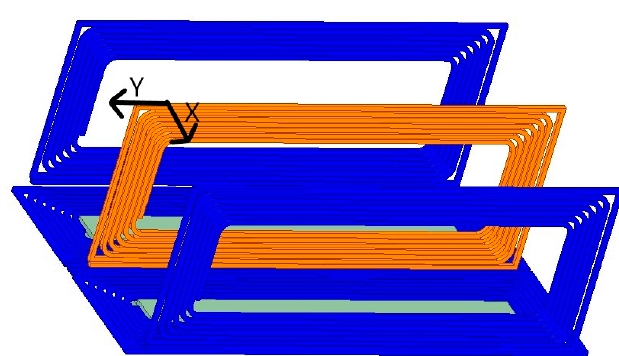
Figure 2. Concave coupling structure of the drone.